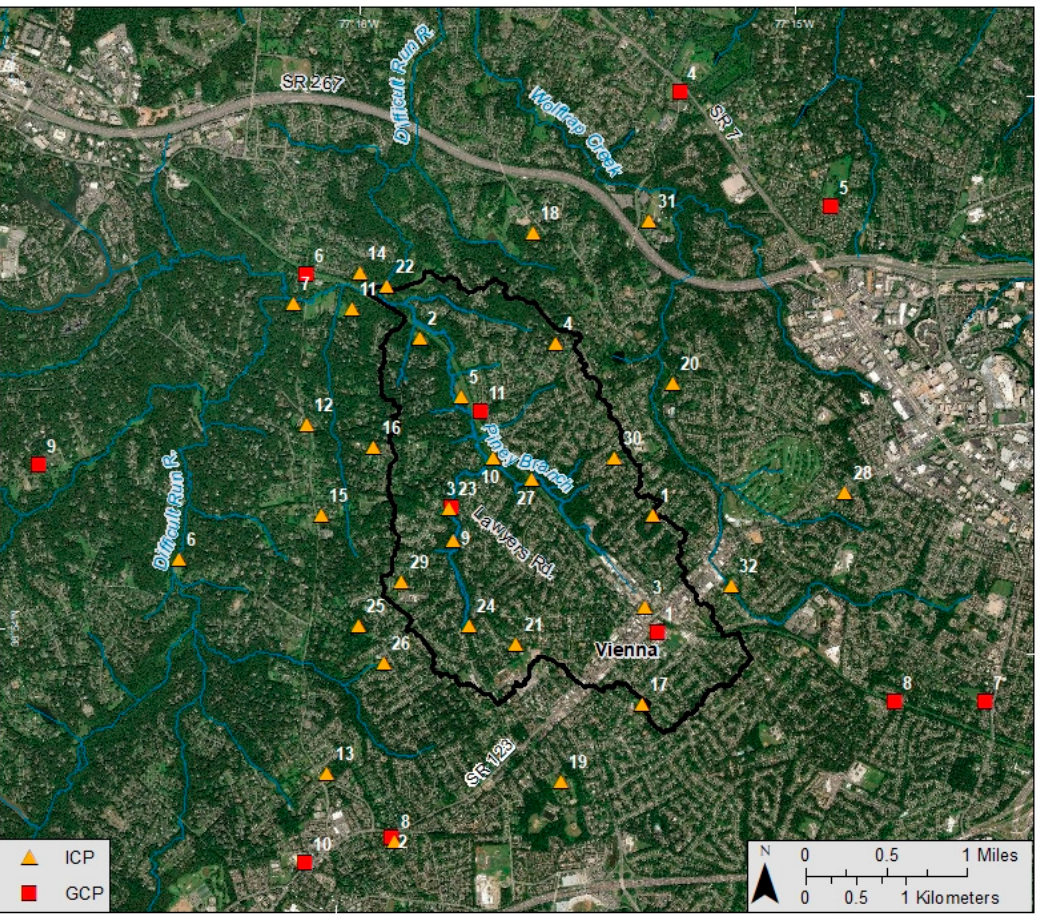
Figure 2. Map showing the locations of the ground control points (GCPs) and independent check points (ICPs).